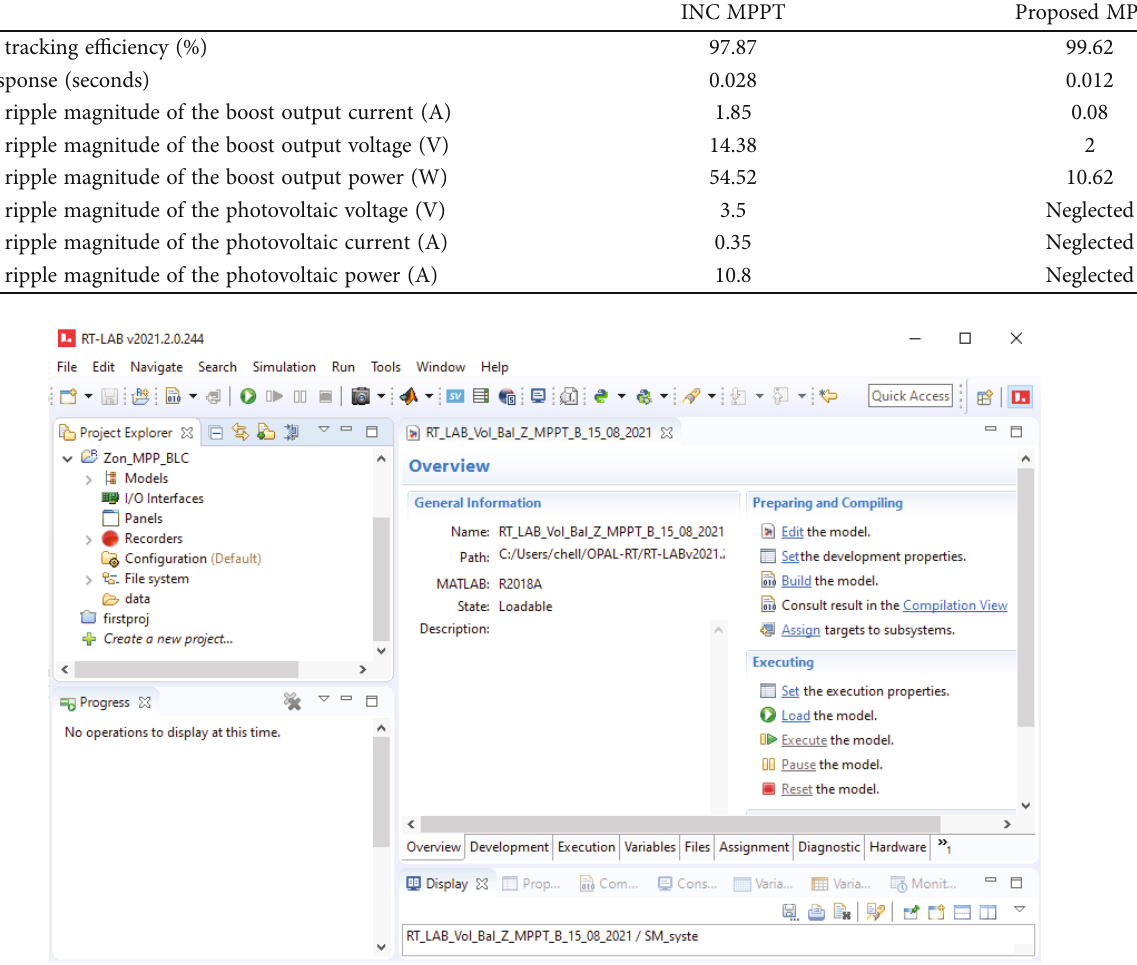
Figure 21: RT-LAB